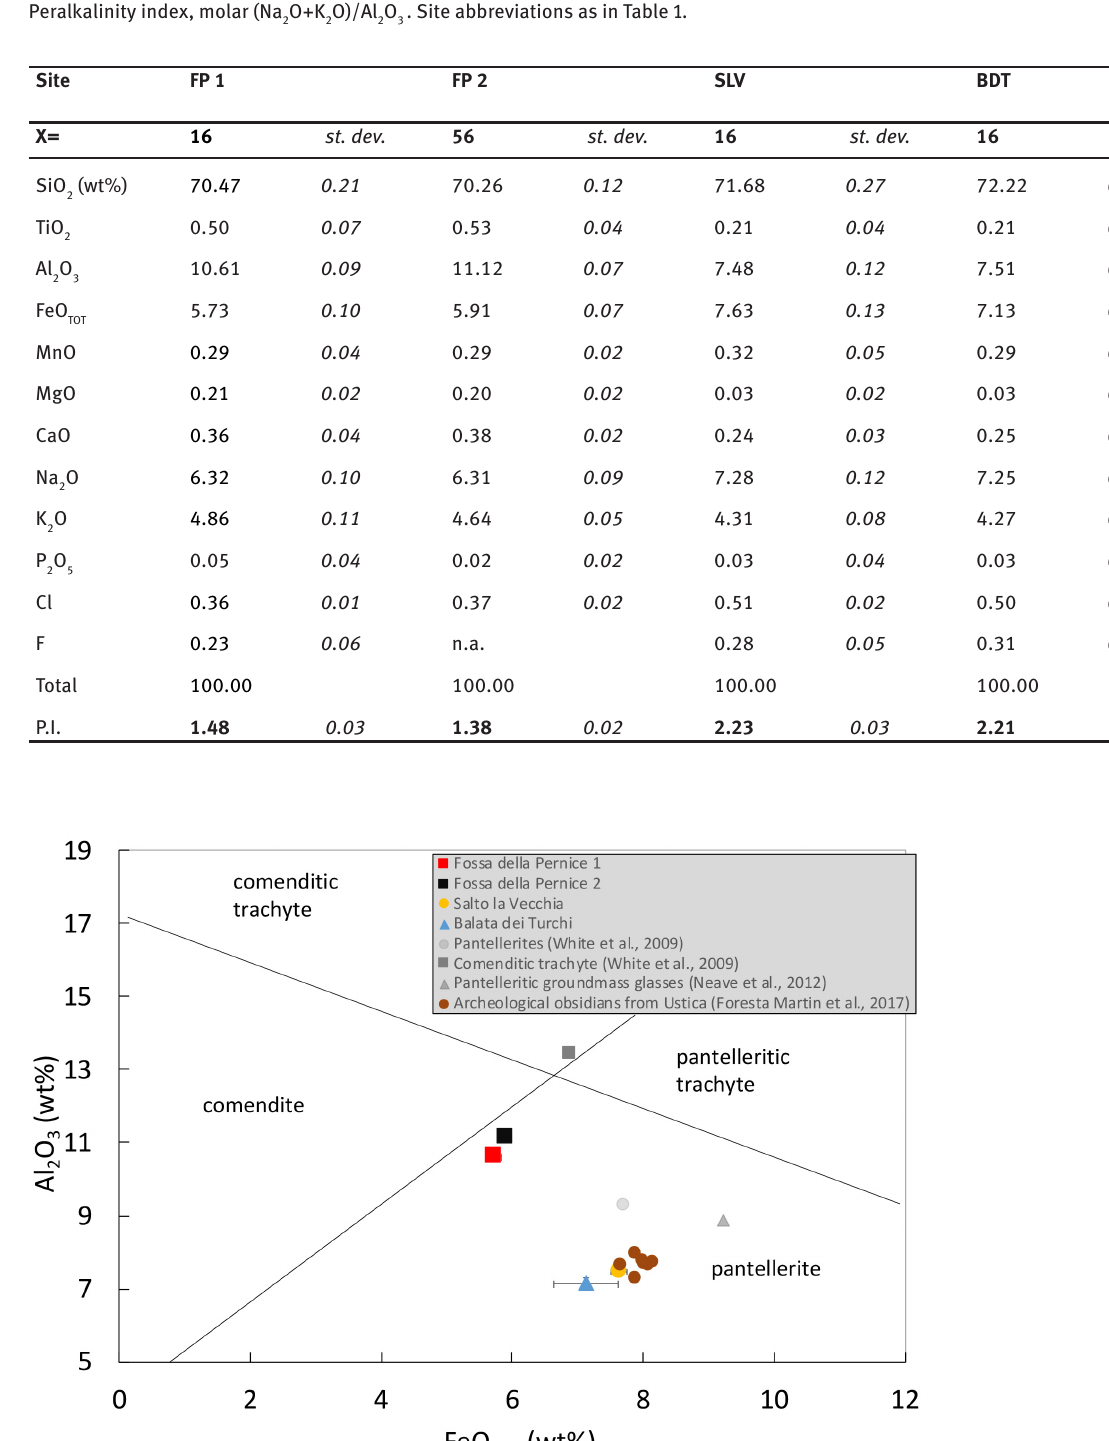
Table 2: Mean and std. deviation (2- s ) of electron microprobe analyses of obsidians. X = n° of analyses for the calculation of the mean. P.I. = Peralkalinity index, molar (Na